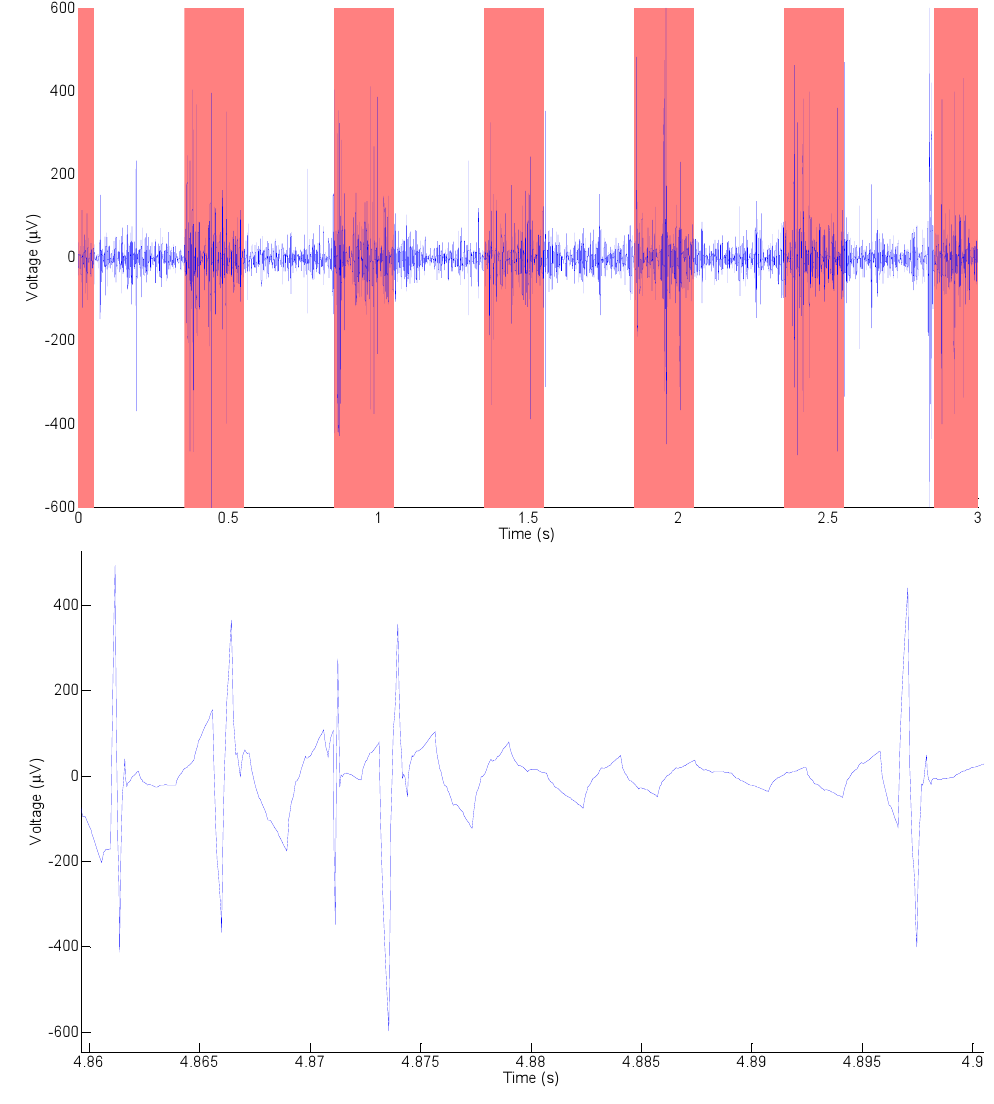
Figure 5. Neural recording from the audio cortex of a guinea pig taken with a neural probe with a diamond electrode. In the top graph, the red bars indicate where auditory stimulus was applied. The bottom graph shows a close up of several action